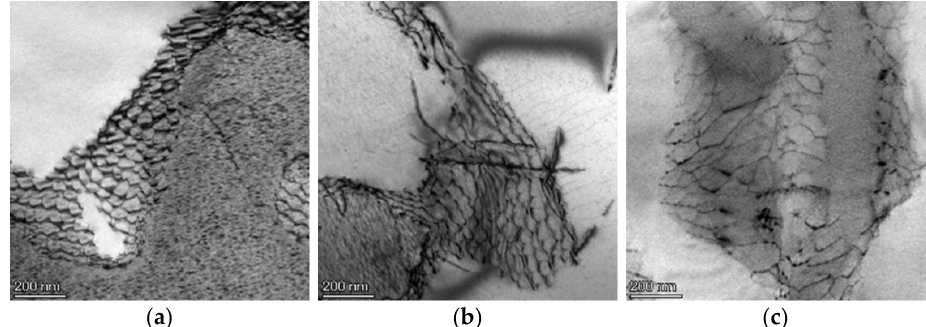
Figure 13. TEM images of ruptured specimens of the alloy with different Co content at 1100 °C/137 MPa: ( a ) 6% Co; ( b ) 9% Co and ( c ) 12% Co.